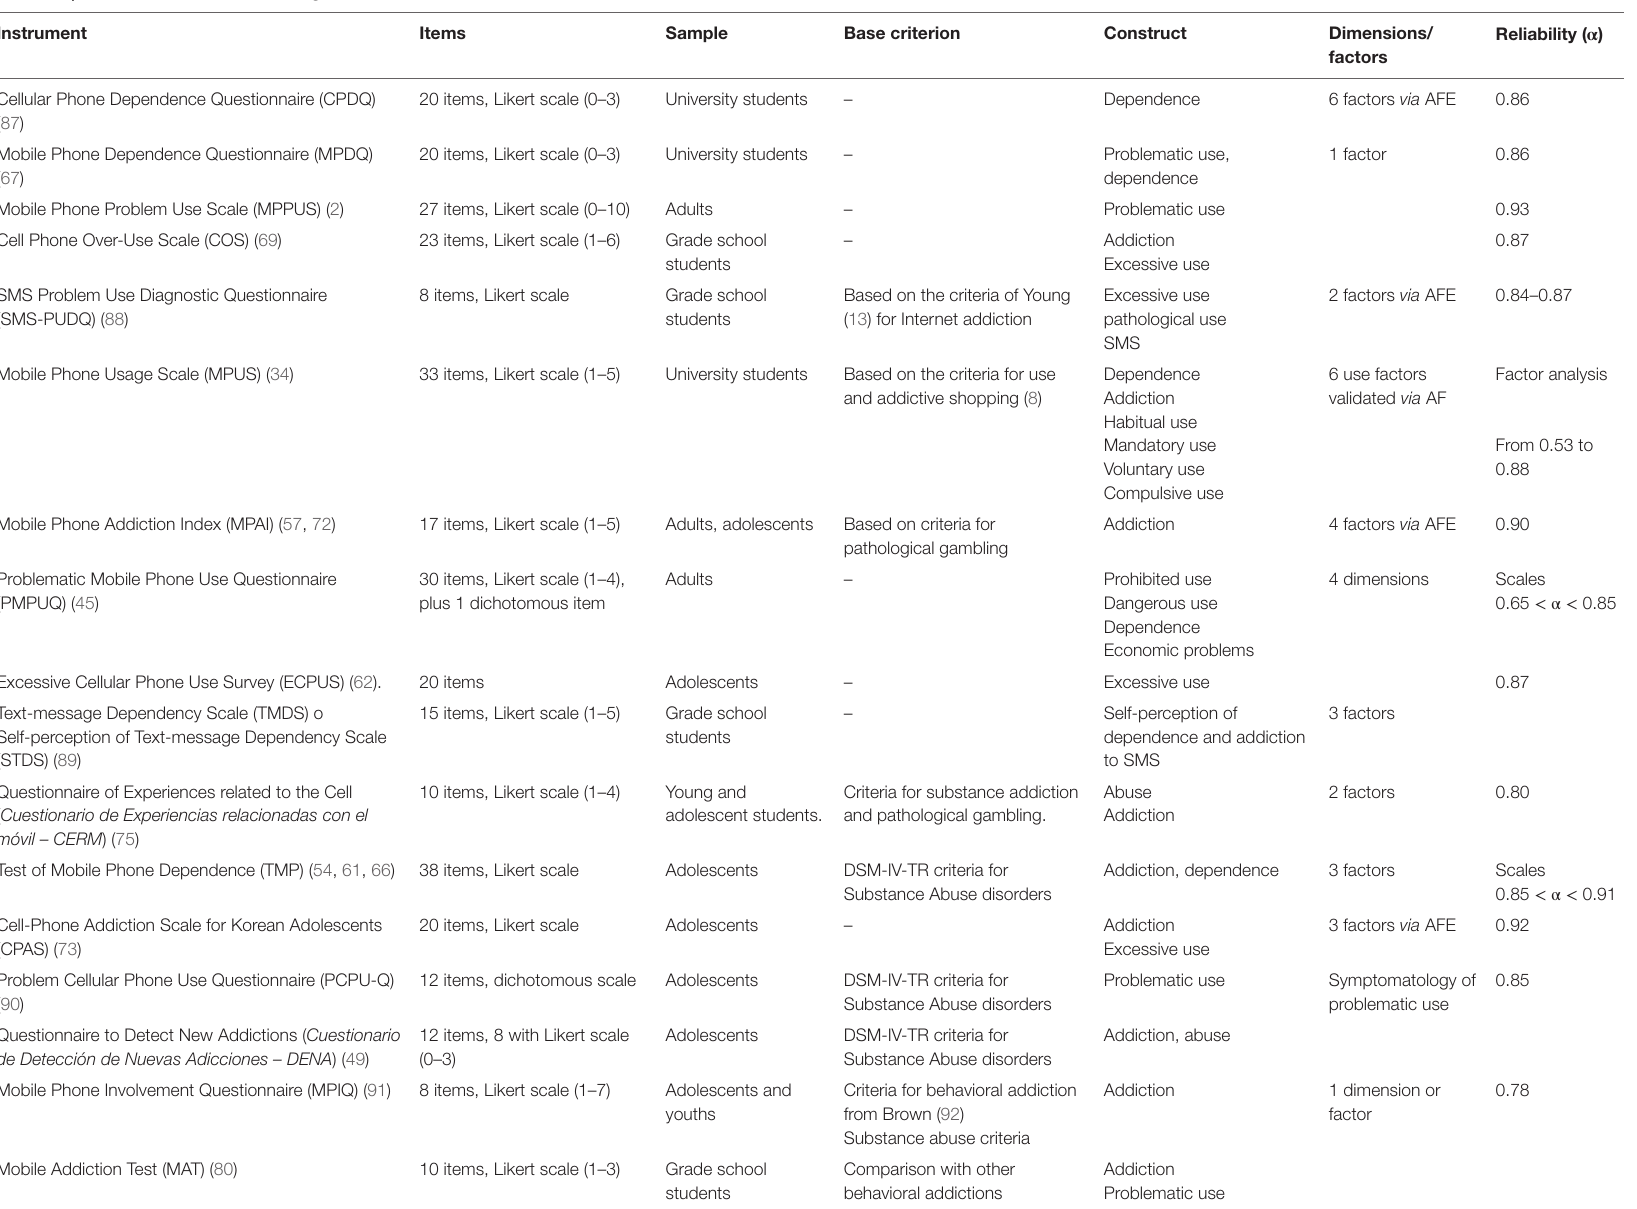
TABLe 3 | instruments and